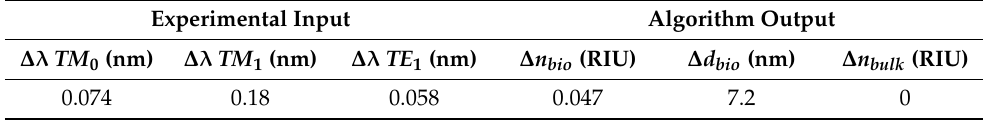
Table 2. Experimental Input and Algorithm Output for Con A Detection.